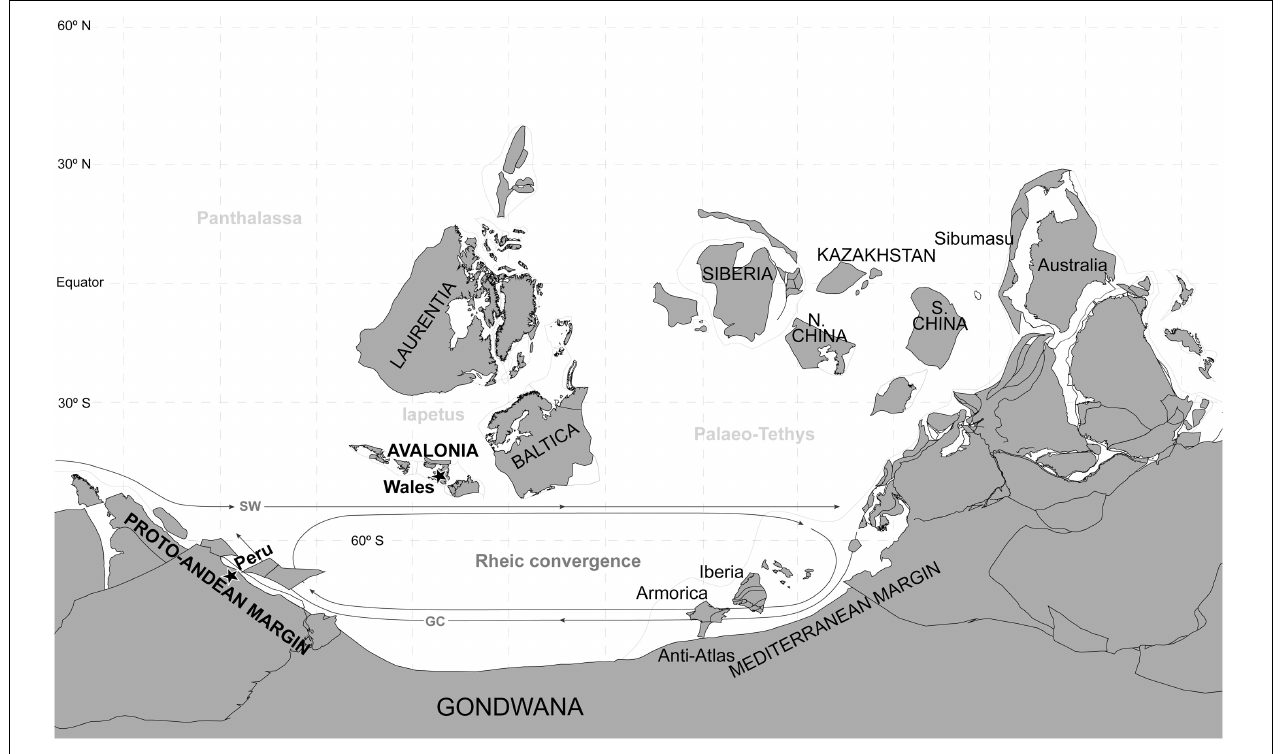
FIGURE 5 | Palaeogeographical reconstruction for the Sandbian (Upper Ordovician), with the location of the compared localities from Peru and Wales and the oceanic currents discussed in the palaeogeographic remarks. SW, Southern Westerlies; GC, Gondwanan Current. Based on Harper et al. (2013), Pohl et al. (2015), and Villas et al. (2015) and Bugplates, and using a Molle wide projection.